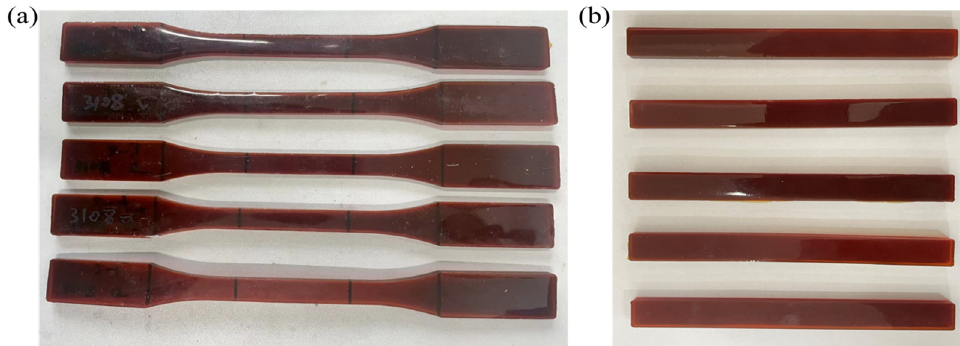
Figure 2. The prepared specimen: ( a ) tensile test specimen, ( b ) bending test specimen.